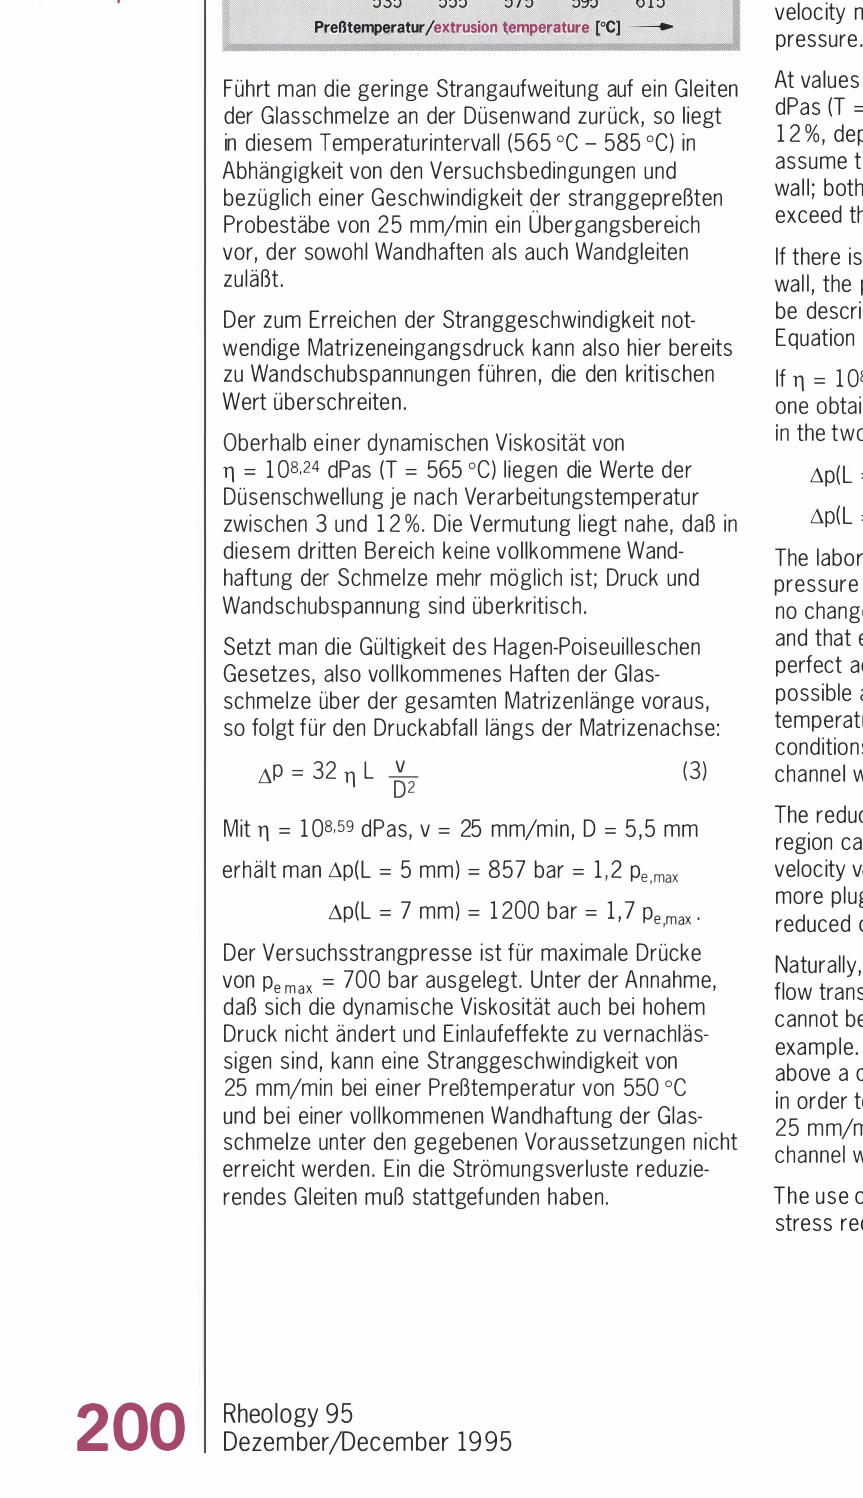
Fig. 5: Die swell aA at an extrudate velocity of 25 mmjmin for (a} 5 mm and (b) 7 mm long dies as a function of extrusion